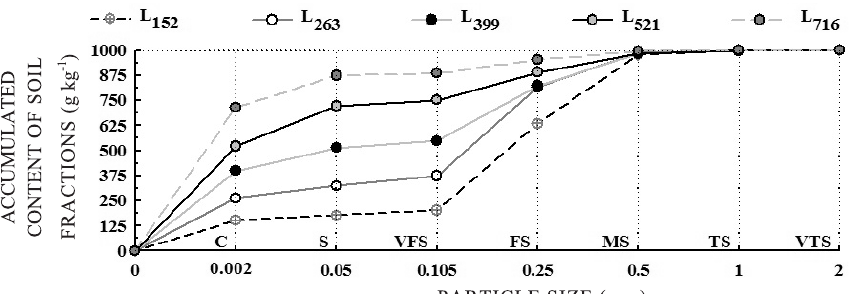
Figure 1. Particle-size-distribution of Latosols (L) in the county of Rio Verde, GO. The subscript number of Latosols indicates the respective clay content (g kg -1 ). Abbreviations: C: clay; S: silt; VFS: very fine sand; FS: fine sand; MS: medium sand; TS: thick sand; and VTS: very thick